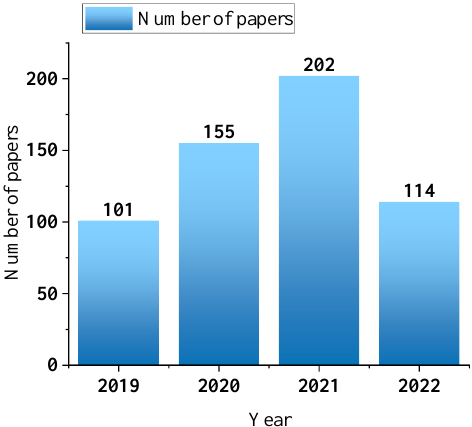
Figure 12. The most recent number of papers on the FPGA neural network accelerator in Web of Science.